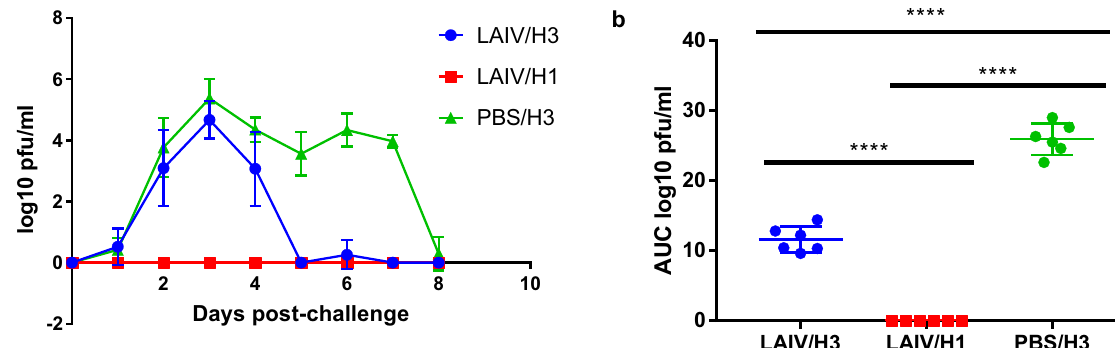
Fig. 4 Nasal wash virus titres following challenge with wild-type viruses. a Mean and SD following challenge. b Area under the curve (AUC) analysis for each group. LAIV/H3 group shed signi fi cantly less virus than control group PBS/H3 (one-way ANOVA, P < 0.0001, n = 6).